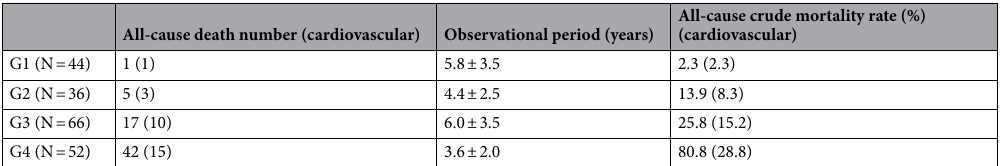
All-cause crude mortality rate (%) (cardiovascular)